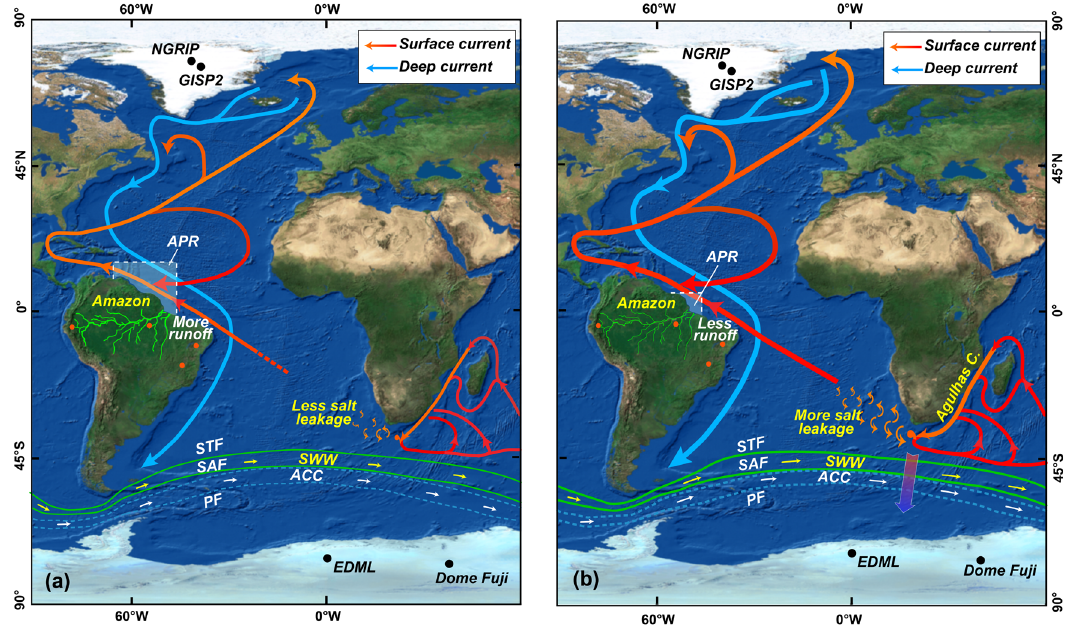
Fig. 4 Conceptual diagram depicting climatic dynamics surrounding the termination of HS4. a , b show centennial-scale changes in the Amazon River runoff and the SWW position prior to the abrupt HS4 termination in Greenland. The SWW and STF shifted poleward, which enhanced the Agulhas Current off the southern coast of South Africa, increased the Agulhas leakage and thus the salt/heat transport from the Indo-Paci fi c Ocean. Striking reduction of the Amazon runoff into the Atlantic Ocean, inferred from SAM records, increased the sea-surface salinity in the Amazon plume region (APR) and therefore increased the northward salt transport by the mean oceanic circulation (red route). Both processes ultimately contributed to AMOC strengthening. ACC Antarctic circumpolar current, SWW Southern Westerly wind, STF subtropical front, SAF Subantarctic front, PF Polar front. White dashed line in a depicts the modern APR, while the APR in b is rather arbitrary. Red dots show locations of SAM speleothem records of the South American Monsoon. Black dots show ice-core locations. The map was created using ArcGIS software and the world map background data are from the Environmental Systems Research Institute (ESRI, https://www.arcgis.com/apps/mapviewer/index.html?layers =